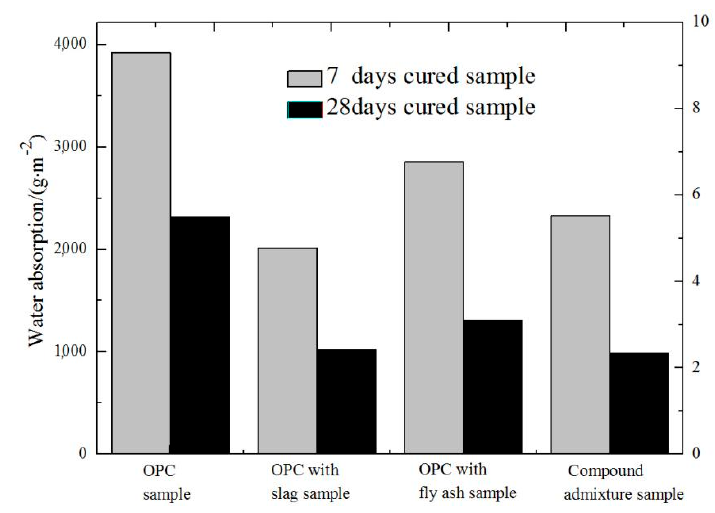
Figure 4. Water absorption of concrete.